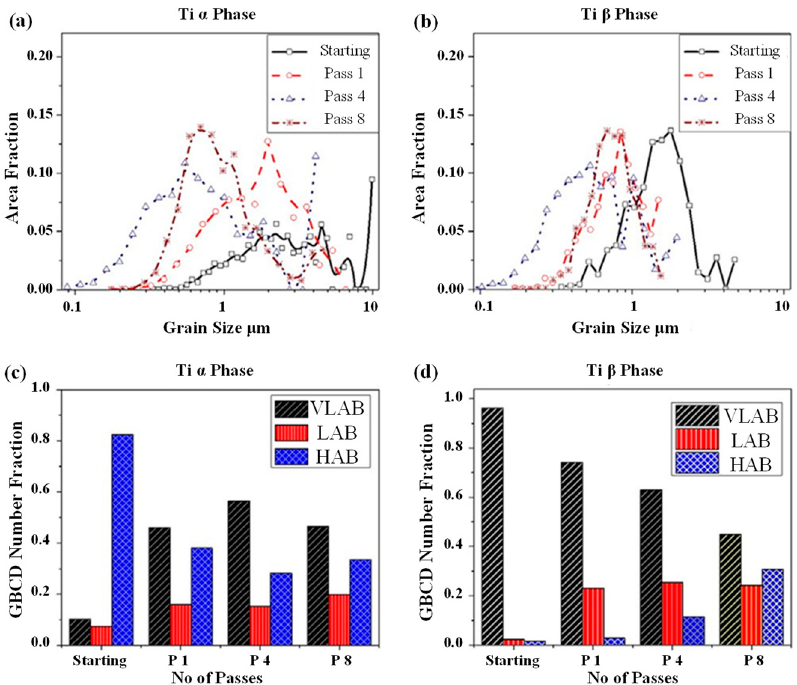
Figure 18. Grain distribution and angular grain boundary distribution of α and β phases under different passes [109]: ( a , c ) is the α phase and ( b , d ) is the β phase. Reproduced with permission from Elsevier Inc.